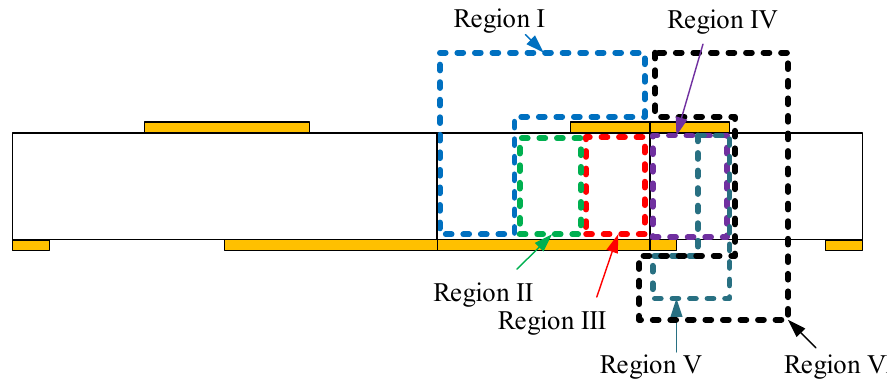
Figure 4. Cross-sectional view of simplified electric field distributions at E-E’.